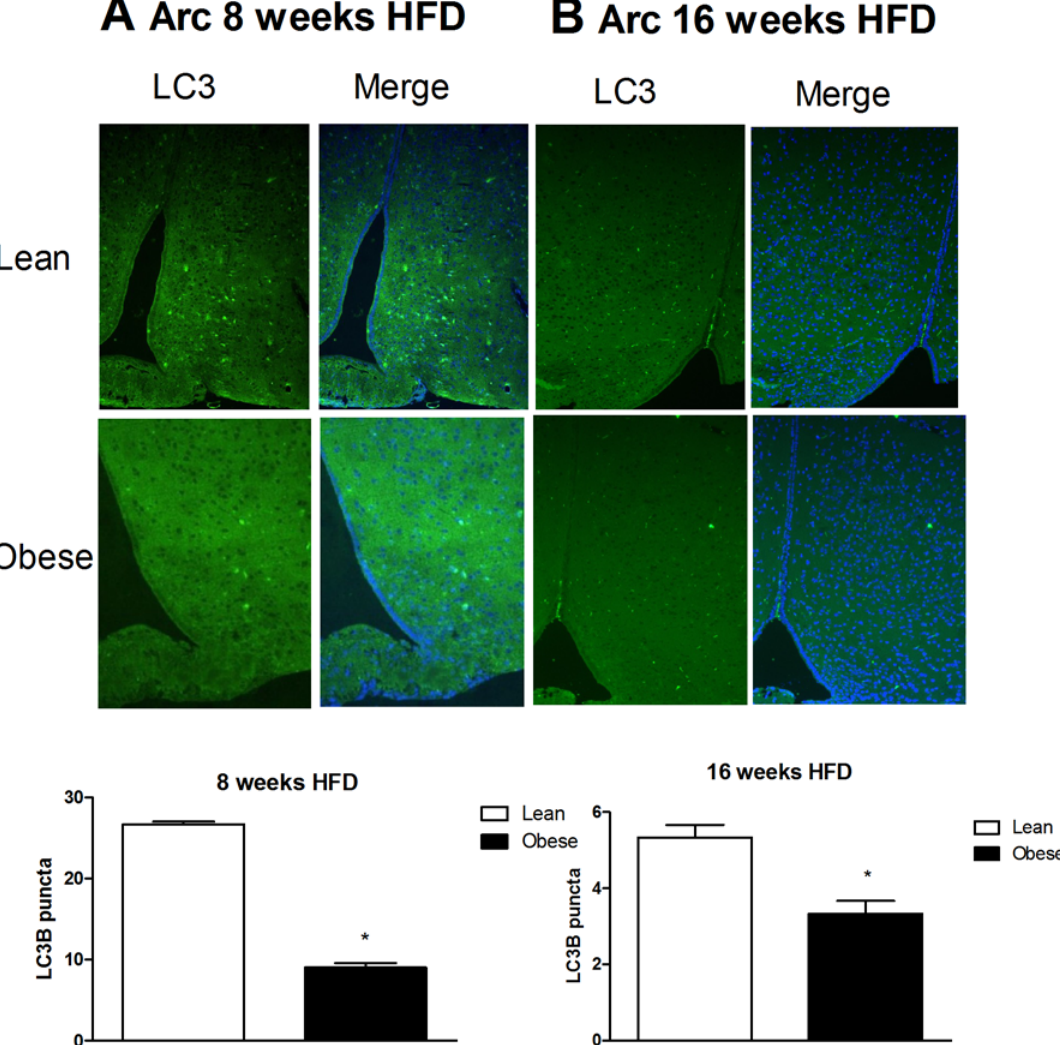
Fig 2. LC3 is expressed in the arcuate nucleus of Swiss mice and colocalizes with the hypothalamic neurons and microglia cells. A. Immunostaining of LC3 (green) in the arcuate hypothalamic nucleus of lean and obese mice (8 weeks of a HFD). B . Immunostaining of LC3 (green) in the arcuate hypothalamic nucleus of lean and obese mice (16 weeks of a HFD). DAPI was used for nuclear staining; n = 3 animals per